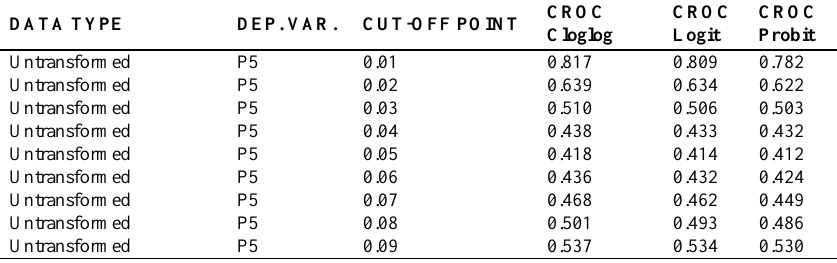
Table 6. Selection of the optimal cut-off point based on the CROC criterion.